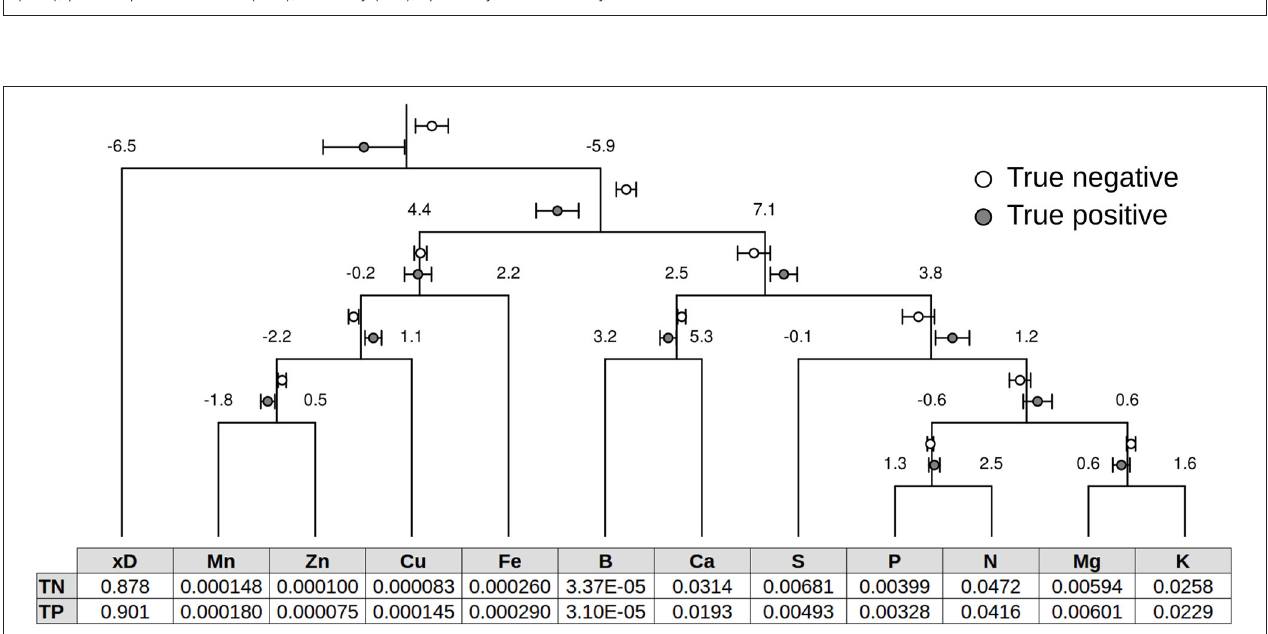
FIGURE 4 | Compositional dendrogram representing the balance scheme. Confidence intervals ( P = 0.05) are shown around the ilr means of true negative (TN) specimens at fulcrums. Concentration centroids back-transformed from ilr means of TN and true positive (TP) specimens are presented in buckets.